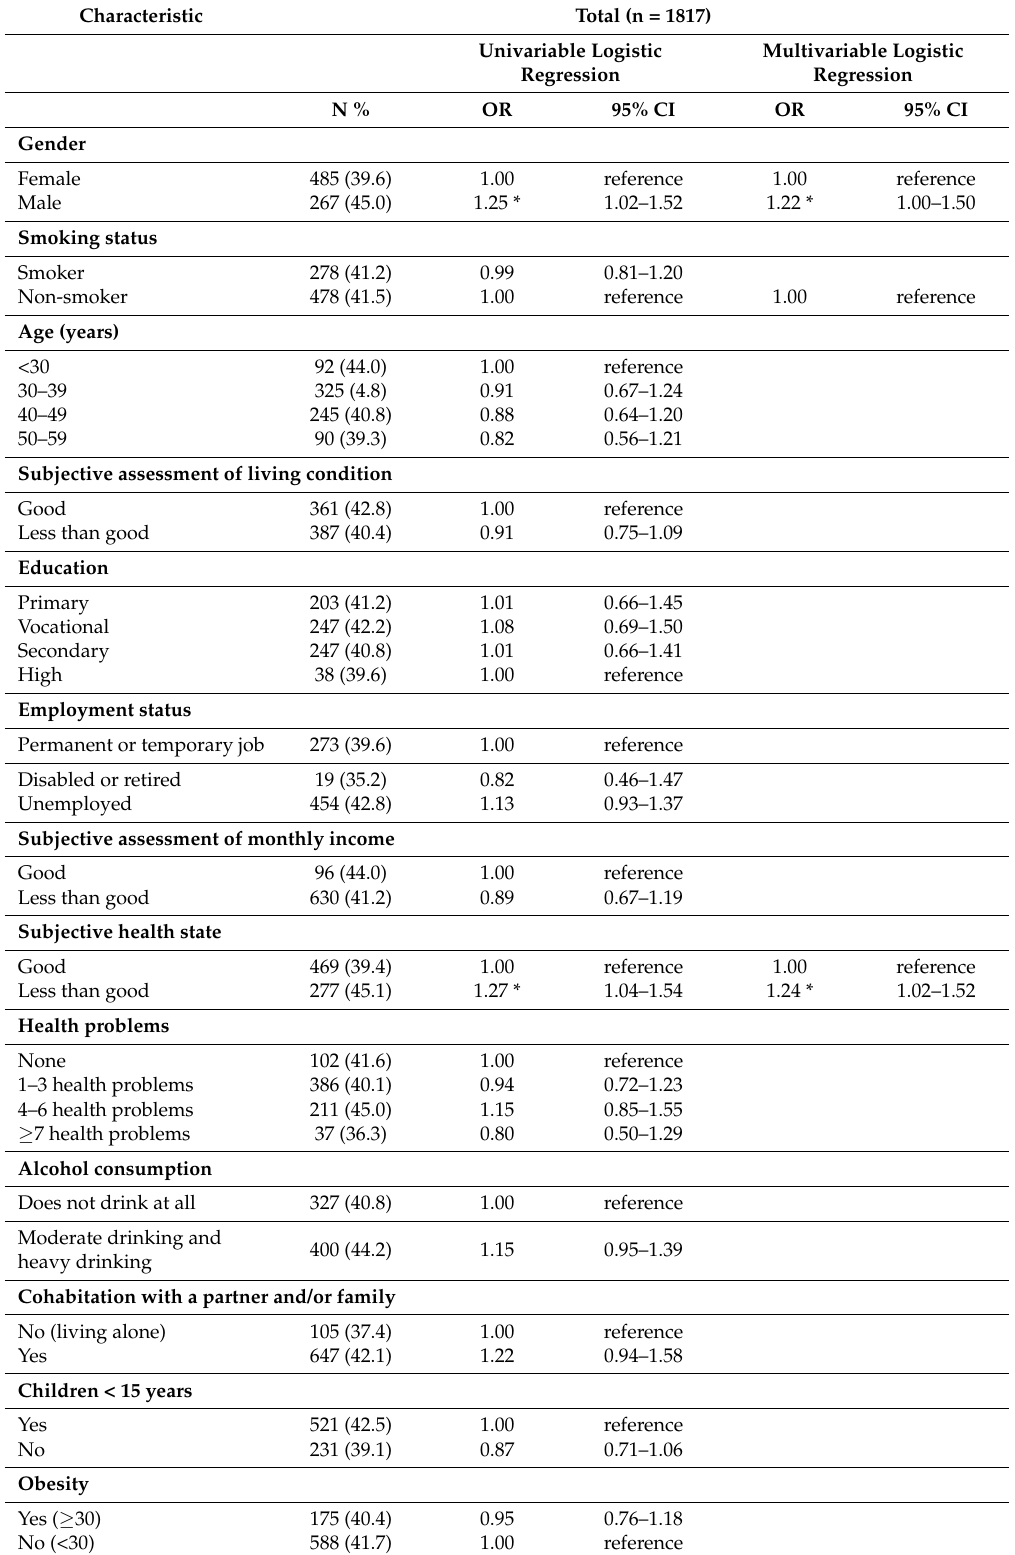
Table 5. Odds ratio (OR) and 95% confidence interval (CI) for inactivity during leisure time and during commuting by socio-demographic